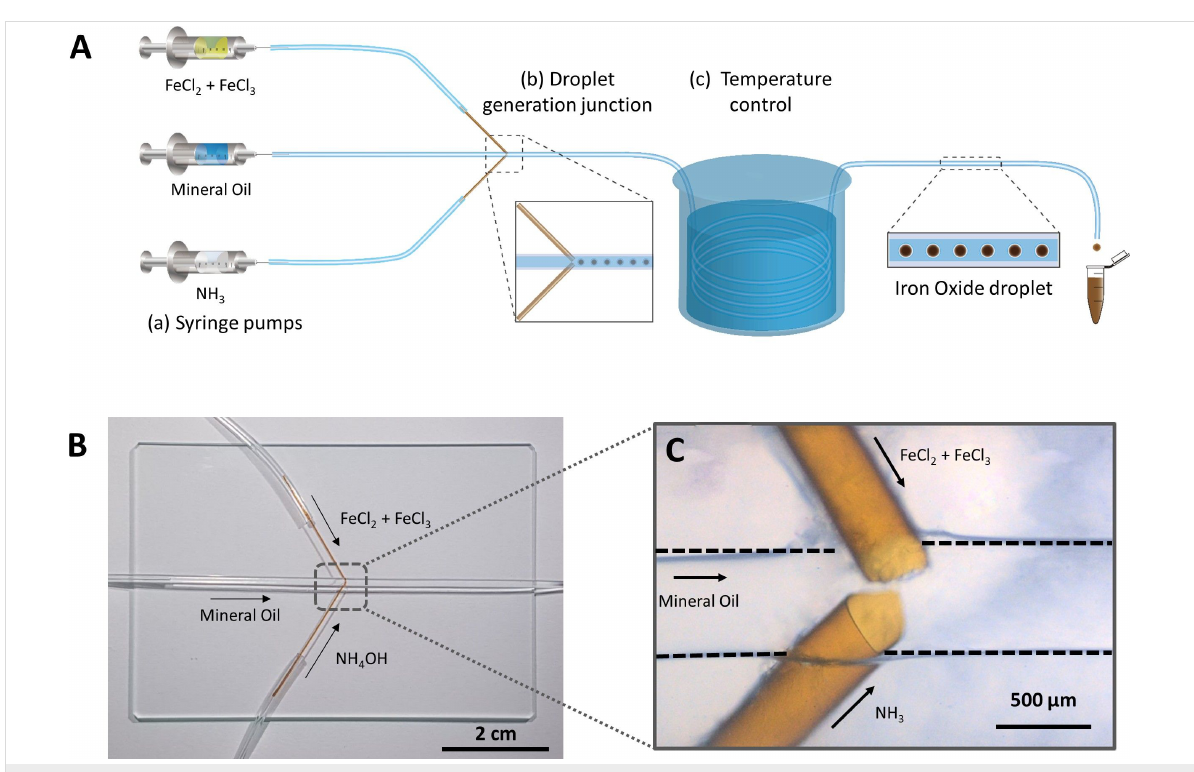
Figure 1: Schematic of the experimental setup showing the three syringe pumps for the reagent solutions and continuous oil phase, the droplet gen- eration junction, the water bath for heating, and collection of droplets in a vial (A). Photograph of the droplet generation junction (B), and microscope image of the droplet generation junction showing the alignment of the fused silica capillaries in the center of the Tygon tubing